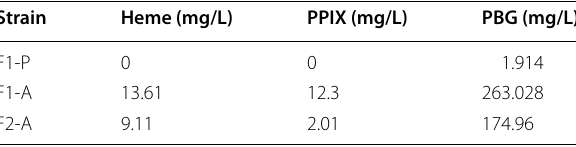
Table 2 Accumulation levels of heme, PPIX, PBG in strains F1-P, F1-A and F2-A